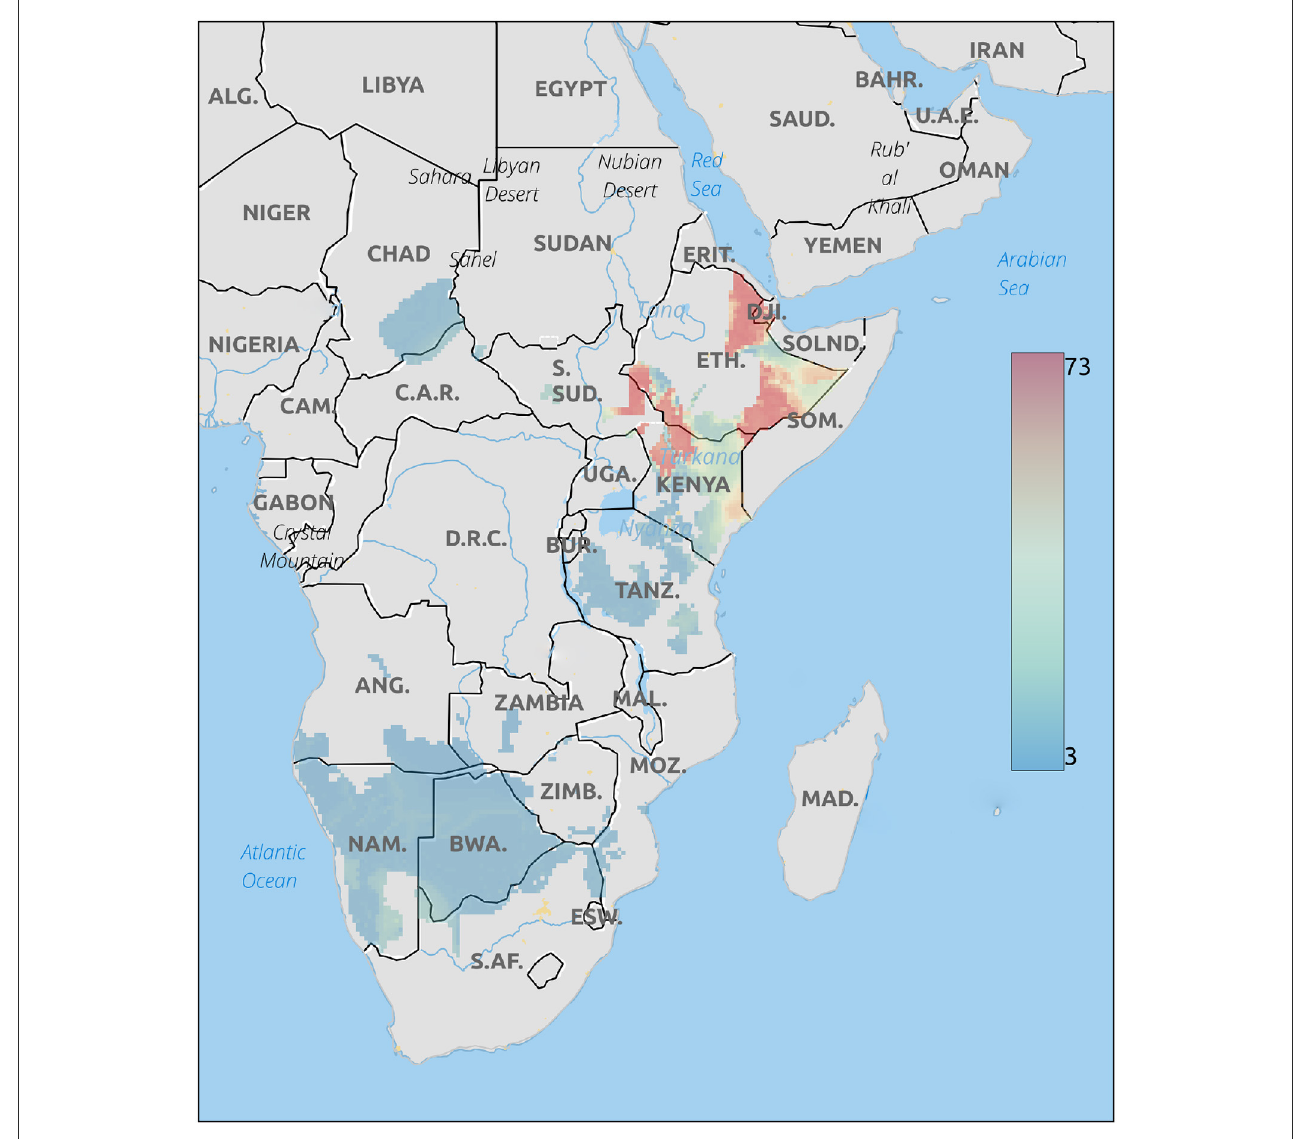
FIGURE3 Probable origins of cheetah cubs rescued from the illegal pet trade based on δ 18 Oisoscapes. Legend is the number of individuals assigned to a pixel based on the odds ratio criterion